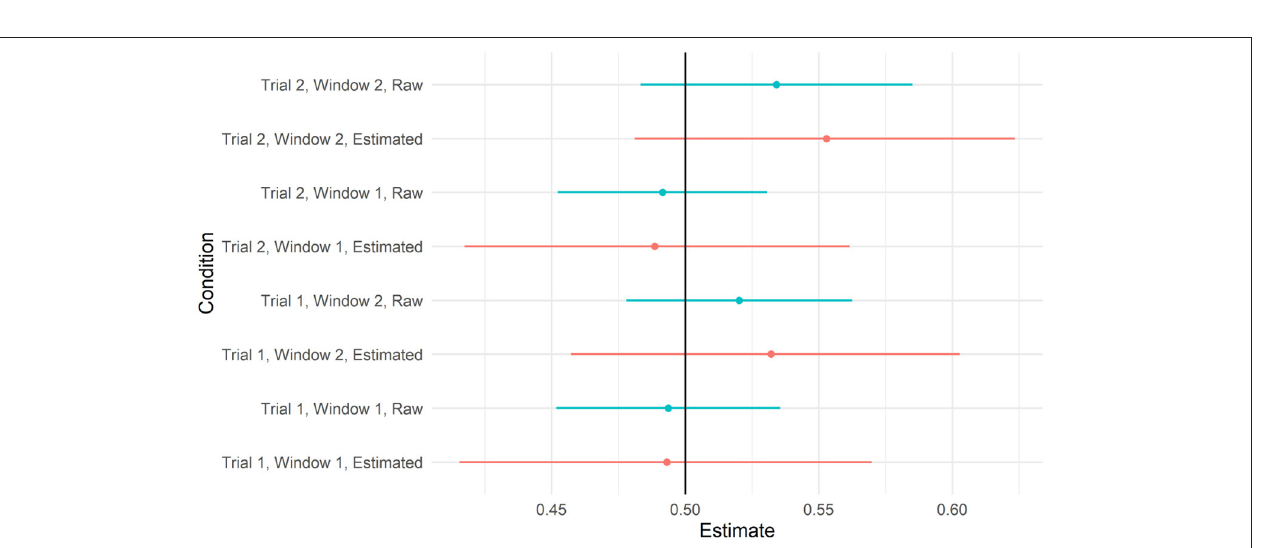
FIGURE 5 | Prior (left pane) and posterior (right pane) distributions for Bayes factor analyses using Exponential (1) as the prior distribution. Xs represent sample means from Gertner et al. (2006), and O (right pane only) represents the sample mean from this study. The Bayes factor comparing these models supported the null (BF =